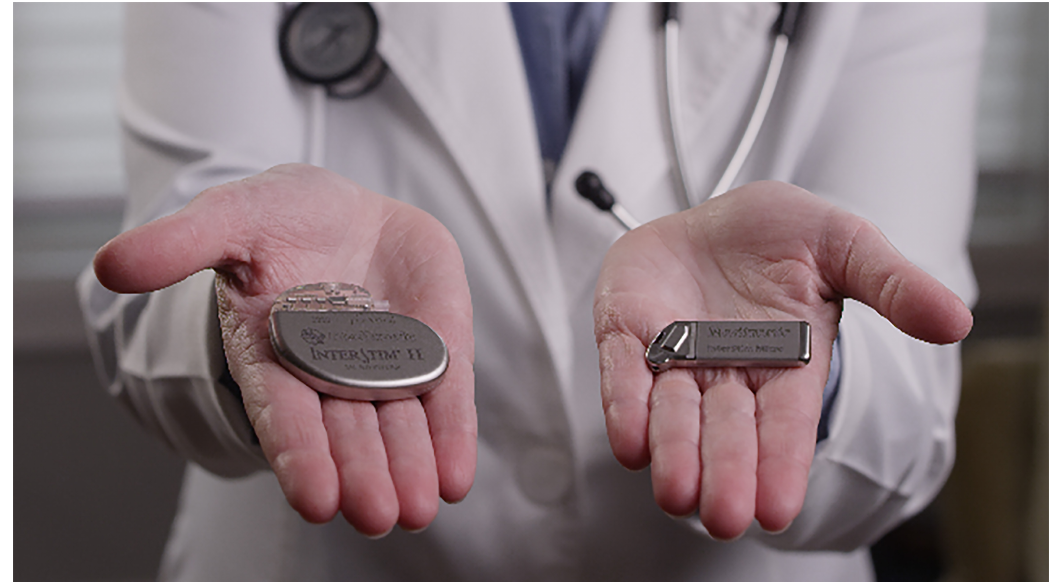
Figure 1 - Size difference between the InterStim™ II (non-rechargeable) and the InterStim™ Micro (rechargeable) implantable pulse